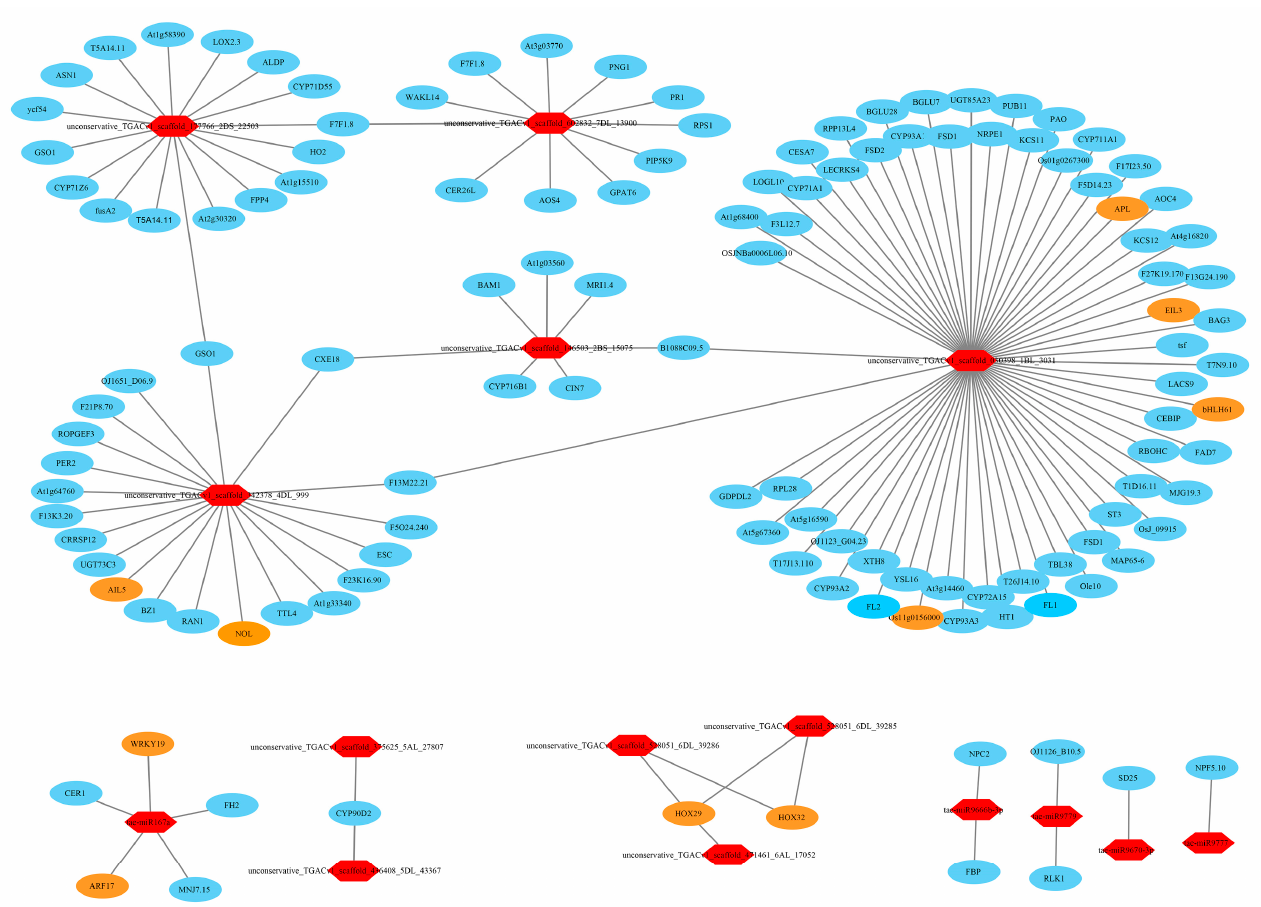
Figure 6. A part of the 372 negative microRNA (miRNA)–mRNA interaction pairs (regulation network) in tiller primordia. Red hexagons represented the highly expressed miRNAs in tiller primordia. Ovals represented the target genes of miRNAs. Yellow ovals represented transcription factors (TFs). Higher resolution image is shown in Figure S8.